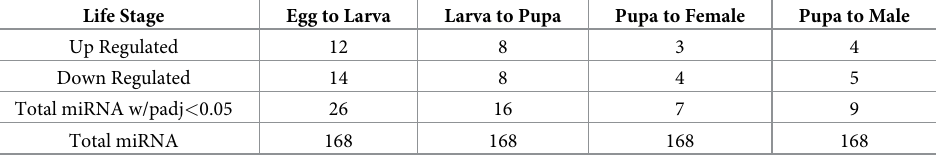
Table 2. microRNA with statistically significant regulation between life stages of novel BSF microRNA with the same seed as known arthropod microRNA.